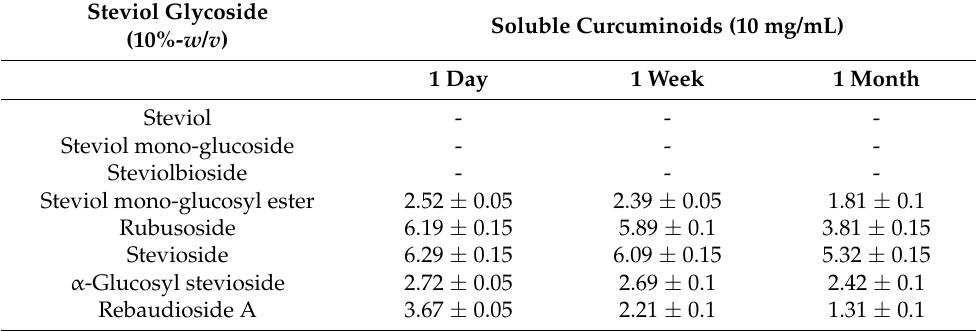
Table 2. Stability of the conditions for dissolving curcuminoids using various steviol glycosides. Steviol Glycoside Soluble Curcuminoids (10 mg/mL) (10%- w / v ) 1 Day 1 Week 1 Month Steviol - - - Steviol mono-glucoside - - - Steviolbioside - - - Steviol mono-glucosyl ester 2.52 ± 0.05 2.39 ±